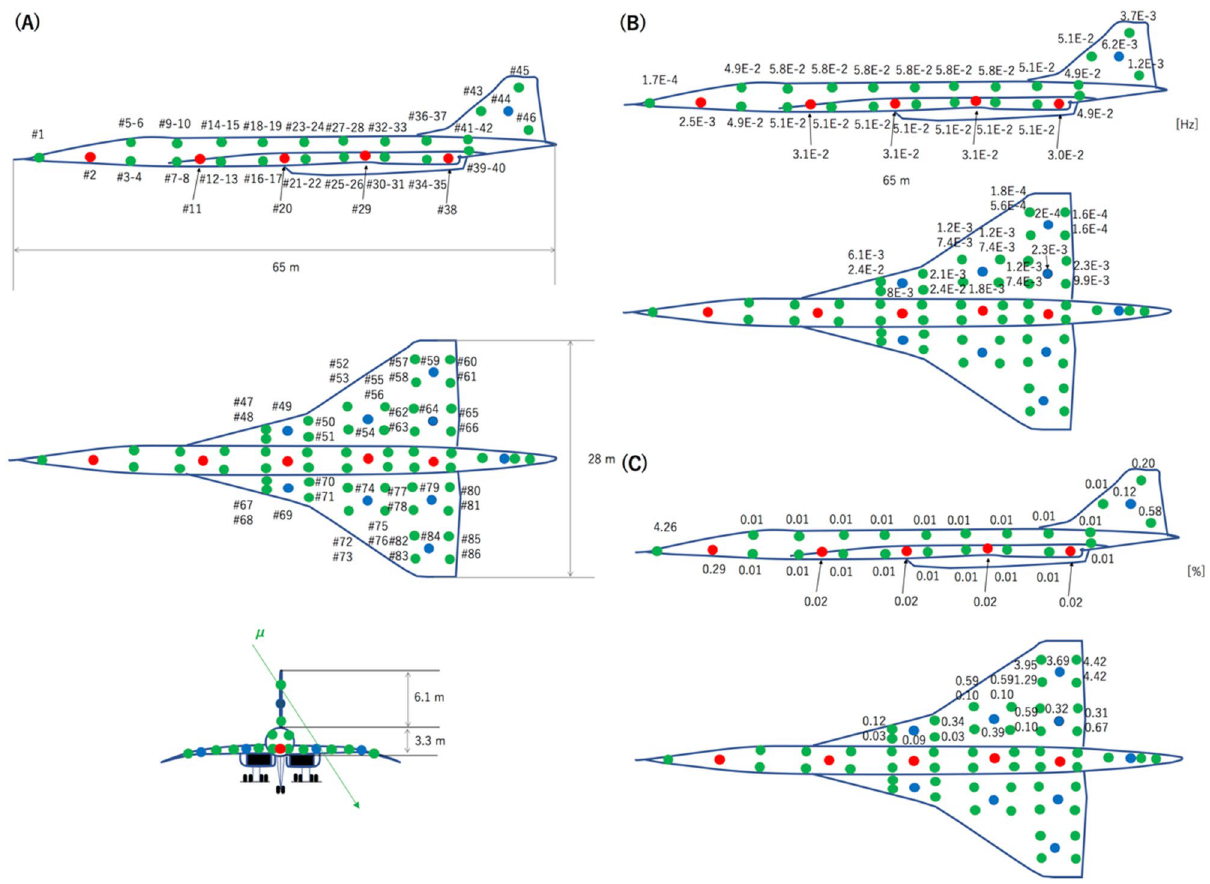
Figure 7. Intelligent health monitoring of aerospace structures using wireless sensor networks proposed by Yuan (NSF Award 0329878). While the sensor-node arrangement follows the Yuan’s proposal, the Concorde was chosen as an aircraft body in this work. The red filled circles and blue filled circles respectively indicate master sensors located inside a cabin and wings. The green filled circles indicate the slave sensors. The identification numbers of the sensors are indicated in ( A ). The calibration frequency is shown in units of Hz in ( B ). The resynchronization error rate is shown in ( C